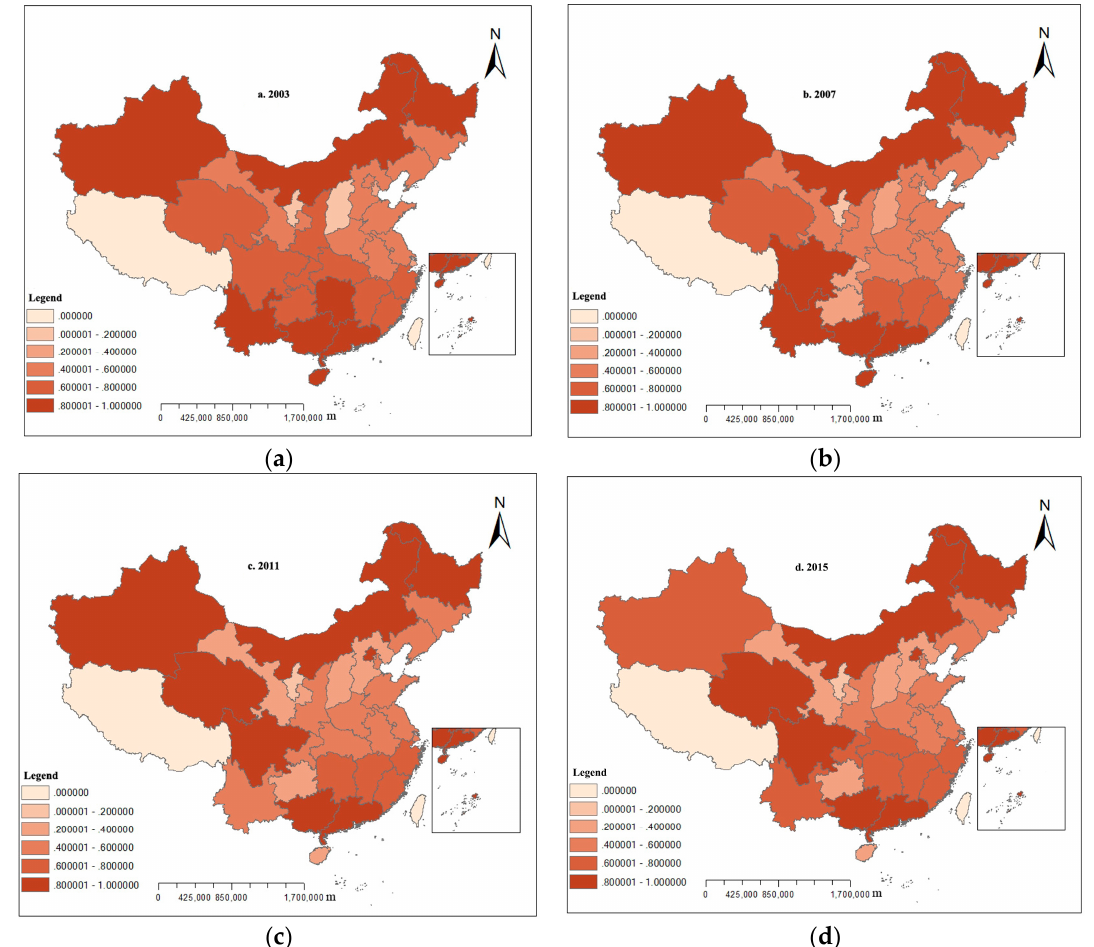
Figure 2. Spatial distribution of provincial land use eco-efficiency in China. ( a – d ) are spatial distribution maps of land use eco-e ffi ciency in 2003, 2007, 2011, and